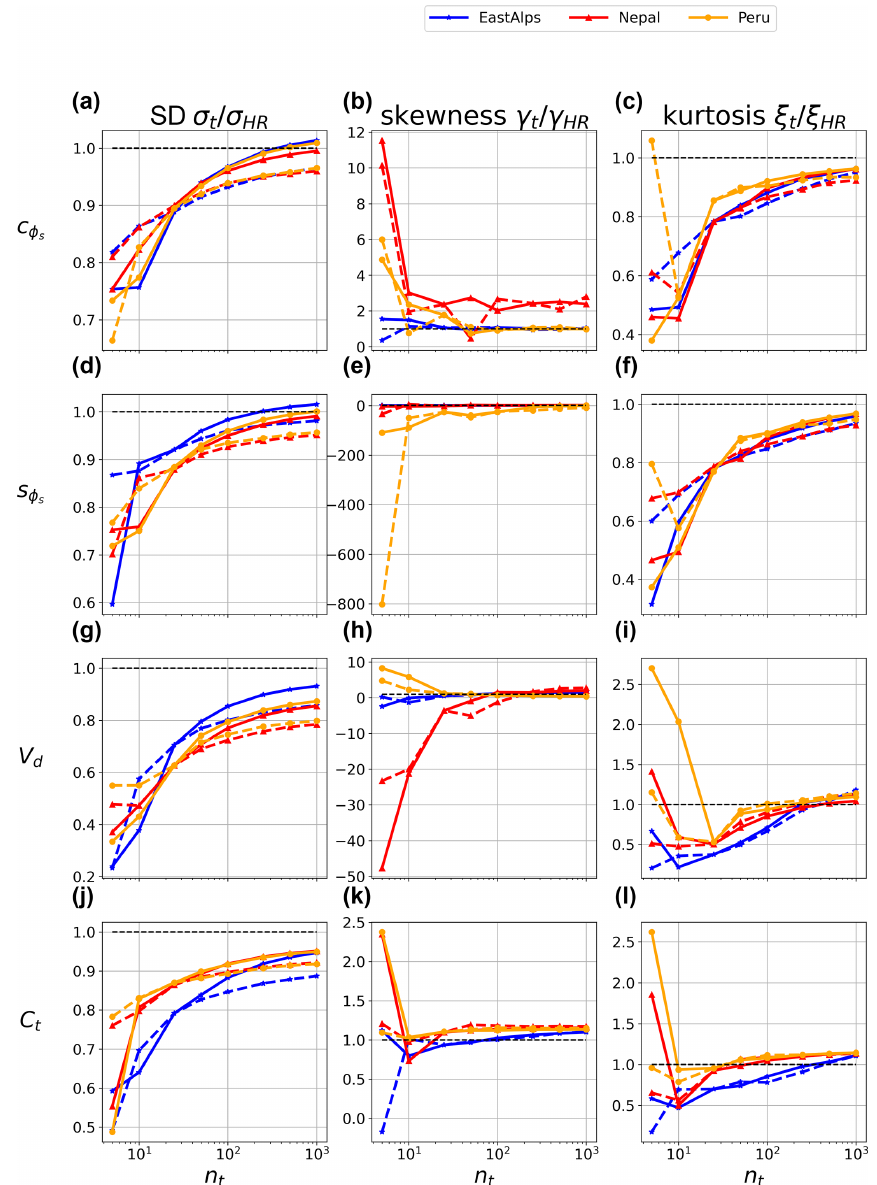
Figure 12. Convergence to the high-resolution terrain properties (slope orientation, sky view, and terrain view) obtained by increasing the number of tiles used in the parameterization. Two different tiling schemes are shown, obtained by fixing the number of hillslopes ( k = 5) and varying that of sub-grid units p (continuous lines) or by fixing p = 5 and varying k (dashed lines). Results are reported for terrain